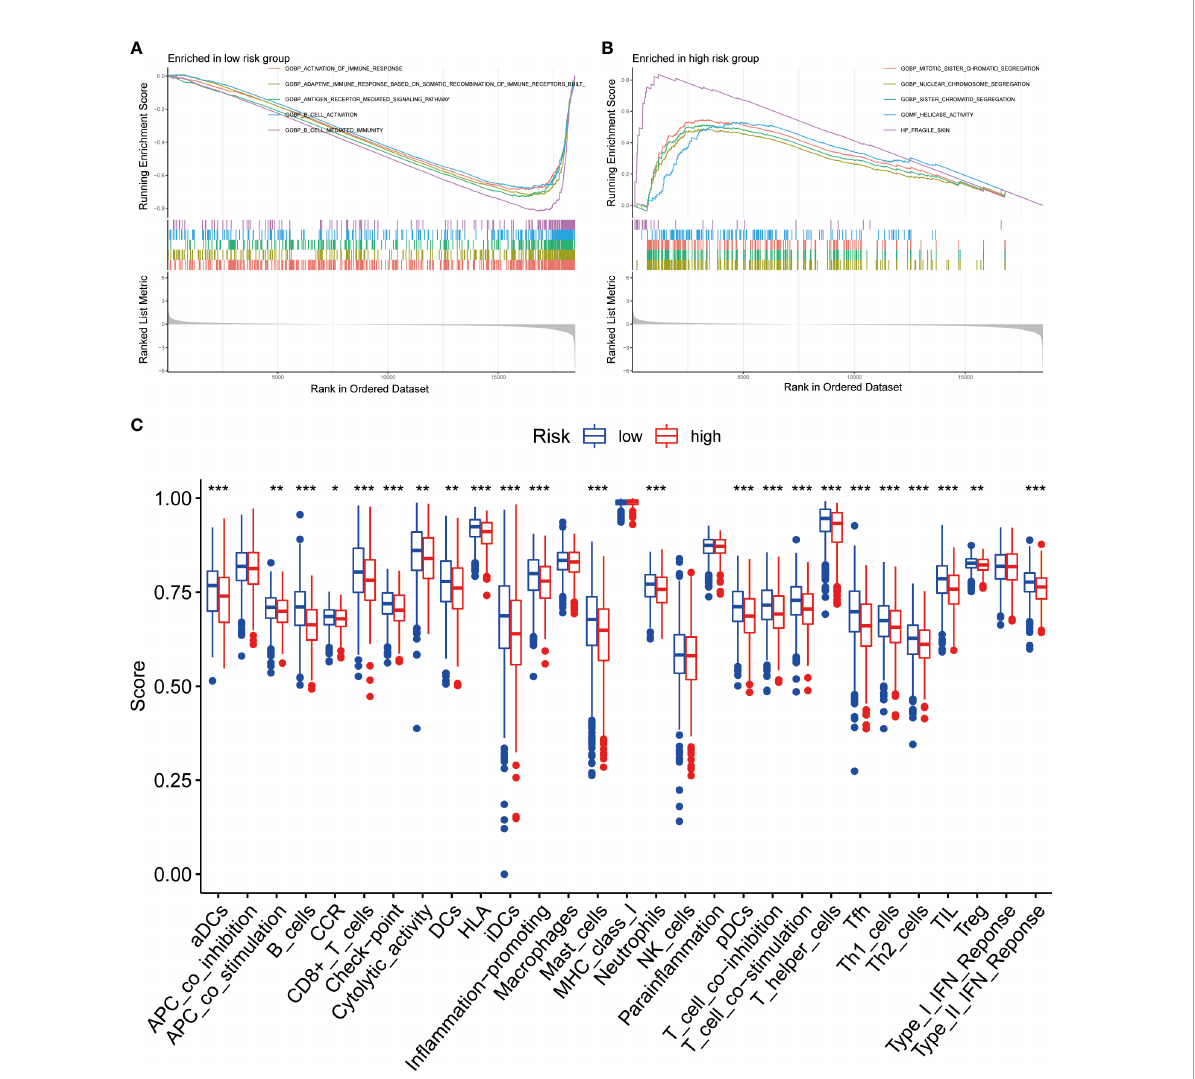
FIGURE 7 Function enrichment analysis of BRGPs signature in NSCLC. (A, B) . The GSEA analysis reveals the fi ve most signi fi cant enrichment pathways in low- (A) and high-risk (B) NSCLC patients. (C) The ssGSEA analysis reveals that the relative enrichment score of 29 immune related signatures in NSCLC patients with high and low risk scores. BRGPs, B cell-related gene pairs; NSCLC, non-small cell lung cancer; GSEA, gene set enrichment analysis; ssGSEA, single sample gene set enrichment analysis. ***, P<0.001; **, P<0.01; *,